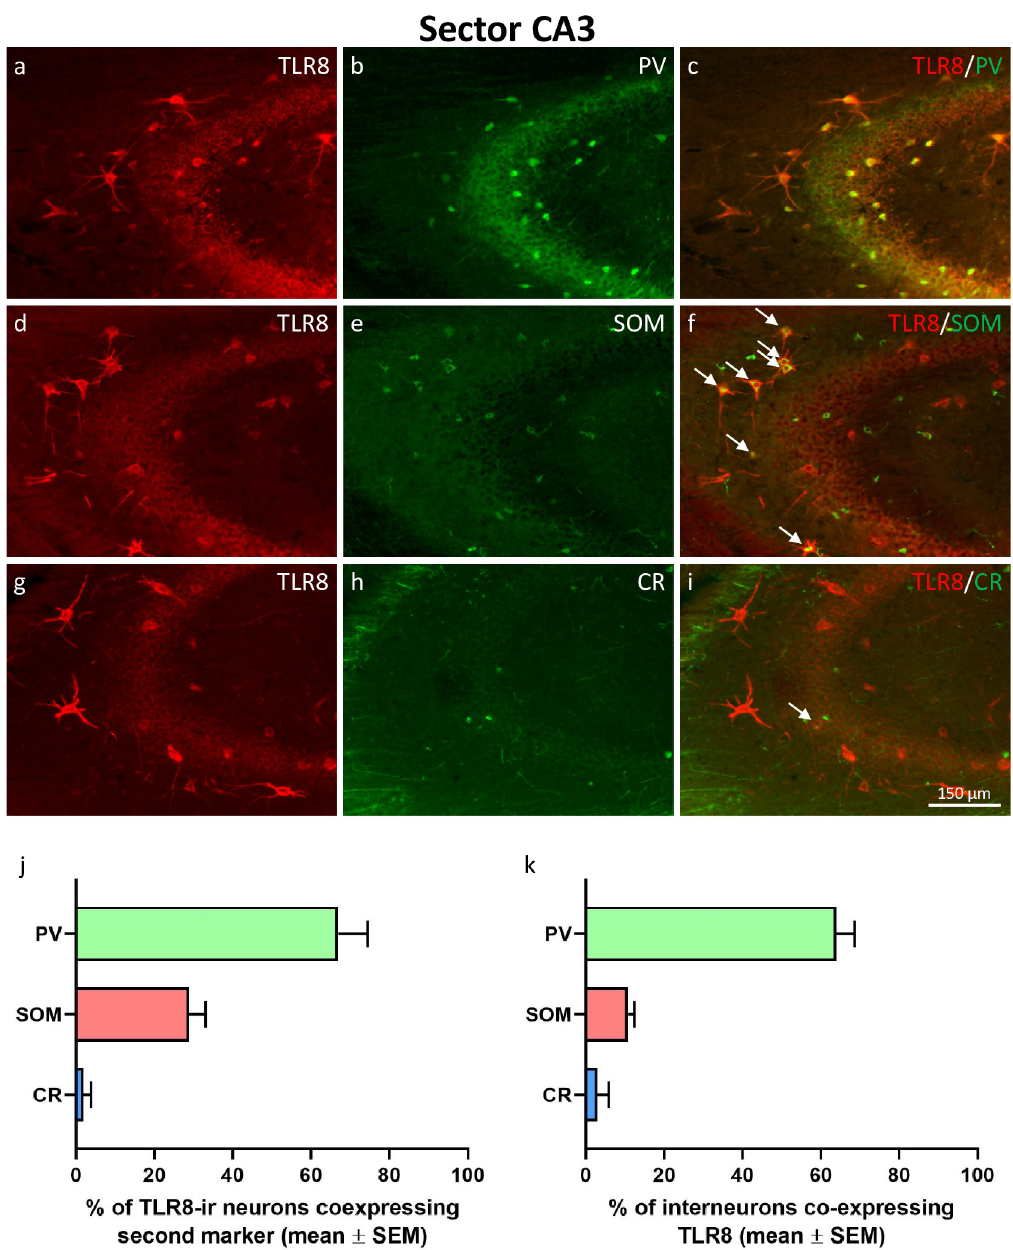
Fig 4. Expression of TLR8 in GABAergic interneurons of hippocampal sector CA3. Double-immunofluorescence of TLR8 together with parvalbumin (PV, a-c), somatostatin (SOM, d-f), and calretinin (CR, g-i). TLR8 was co-expressed in PV-ir interneurons in stratum oriens, stratum pyramidale, stratum lucidum, and stratum radiatum (c). Co-expression of TLR8 together with SOM seemed to be restricted to SOM-interneurons located in stratum oriens (see arrows in f) while SOM- interneurons located in stratum pyramidale, stratum lucidum, and stratum radiatum did not co-express TLR8. Only a fraction of CR-expressing interneurons in sector CA3 co-expressed TLR8 (g–I; see arrow in i). Quantification of co-labeling revealed that 67.0 ± 7.49% of TLR8-interneurons also expressed PV, 28.9 ± 4.19% co-expressed SOM, and only 1.9 ± 1.92% co- expressed CR (see panel j). Vice versa, quantification of co-labeling showed that 64.0 ± 4.56% of PV-interneurons, 10.7 ± 1.72% of SOM-interneurons, and only 2.9 ± 2.94% of CR-interneurons co-expressed TLR8 (see panel k).